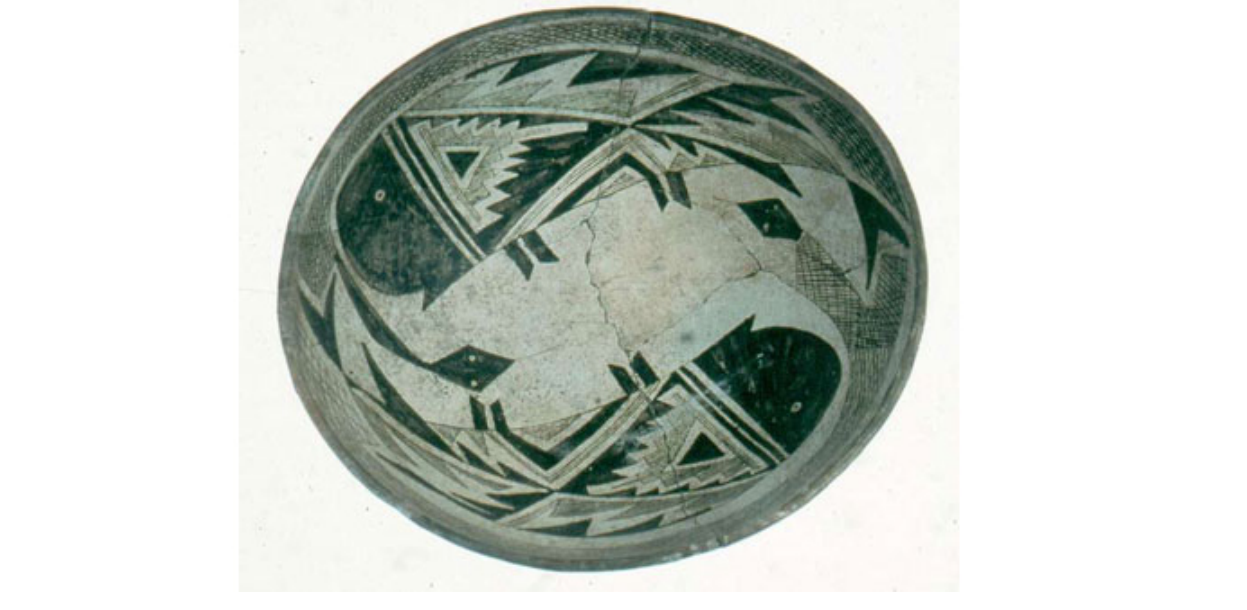
Fig. 3 . Classic Mimbres black-on-white bowl dating to the end of that period (ca. 1130